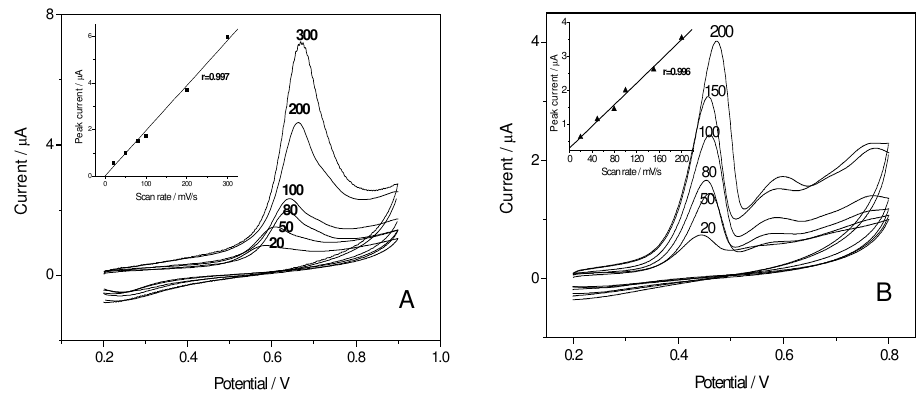
Figure 4. CVs of 10 (cid:1) M prochlorperazine (A) and ethopropazine (B) on DEC SAM/Au in a sodium carbonate buffer (pH 10). Scan rates are as marked on the curves, accumulation time: 60 s. Insert: variation of peak current with scan rate.